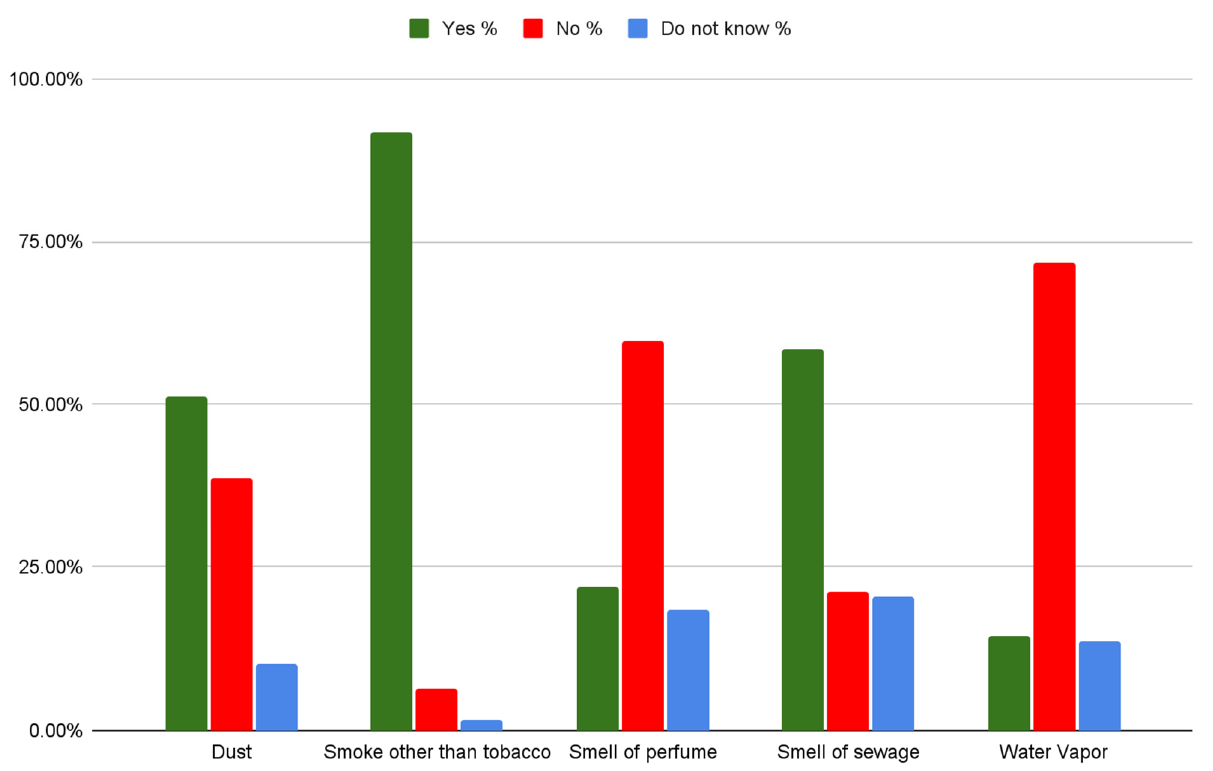
Figure 2. Answers to the question “Which of the below do you think are air pollutants?”